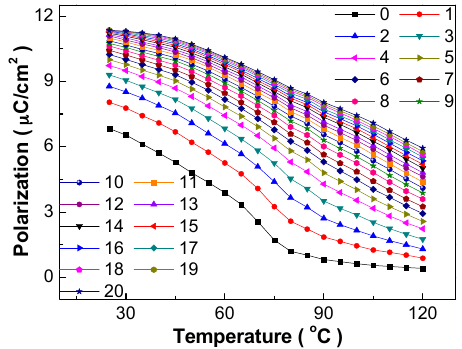
Figure 2. Temperature dependence of polarization of the BCZT-Li ceramics at different electric fields. The unit of the electric field shown by different lines and symbols in the figure is kV/cm.